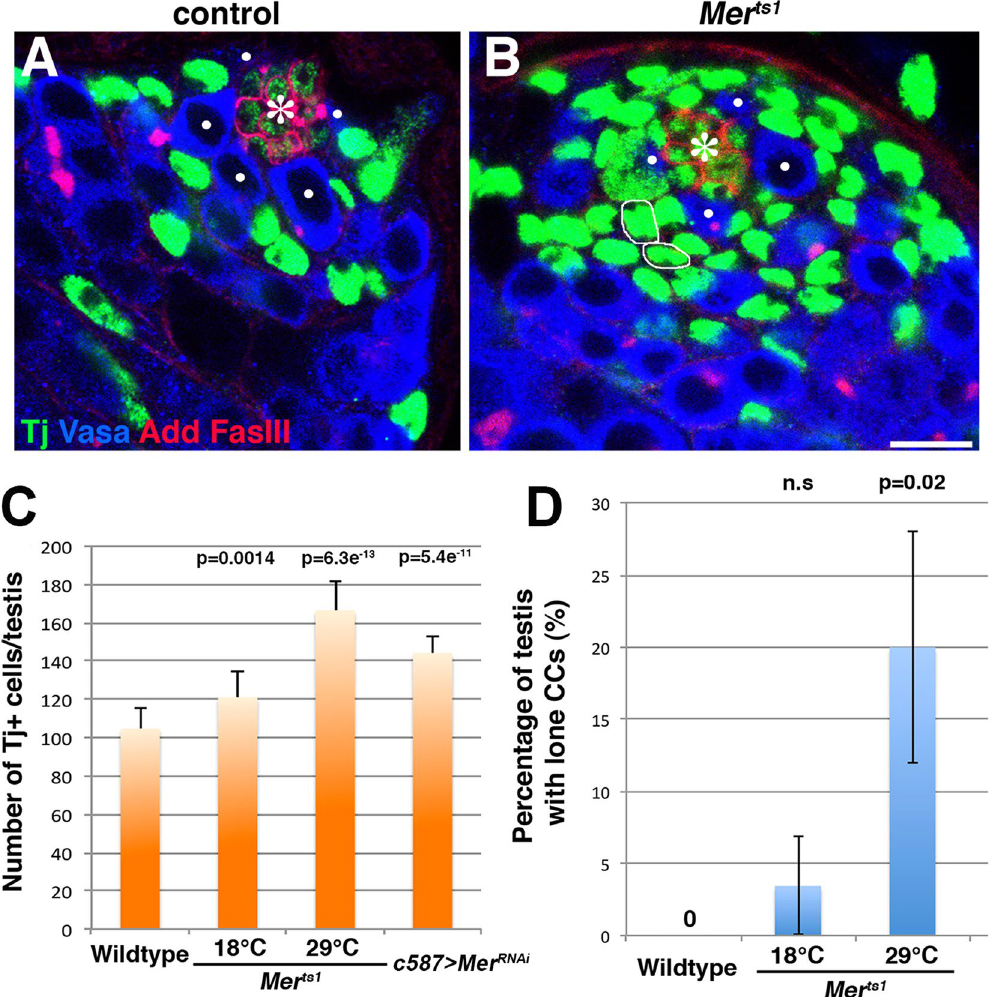
Figure 2. CCs are increased in number upon loss of Mer function.( A and B ) The testis apical tip stained for Tj (green), Vasa (blue), adducin-like (Add), and fasciclin III (Fas III, red) in a control ( A ) and ( Mer ts1 ) mutant ( B ) testis. Circles in ( B ) indicate Tj + cells without clear association with germ cells (“lone CCs”). GSCs are indicated by white dots. Hub ( * ). Bar, 10 µ m. ( C ) The number of Tj + cells/testis in control, Mer ts1 , and c587 > Mer RNAi testes. Data are expressed as the mean ± SD, and p values were obtained using the Student’s t test (two-tailed) by comparing to wild type. N = 15 testes for data point. ( D ) The frequency of testes containing lone CCs in control and Mer mutants. N ≥ 40 testes for data